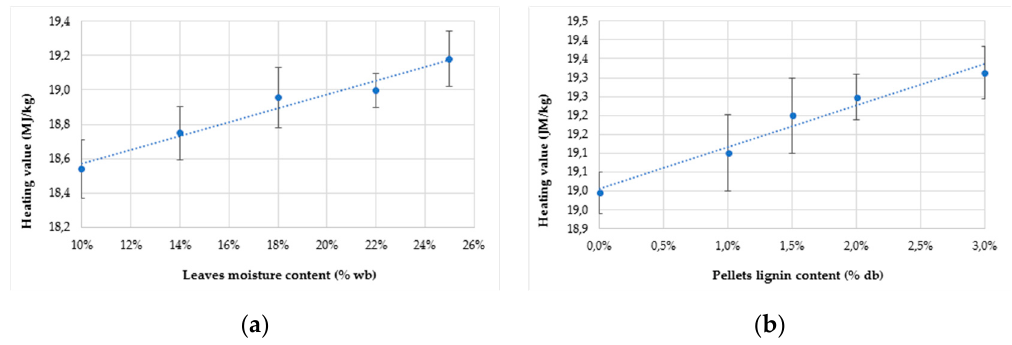
Figure 4. Net heating value (dry basis), ( a ) influence of the moisture content of leaves, ( b ) influence of the lignin content of pellets.